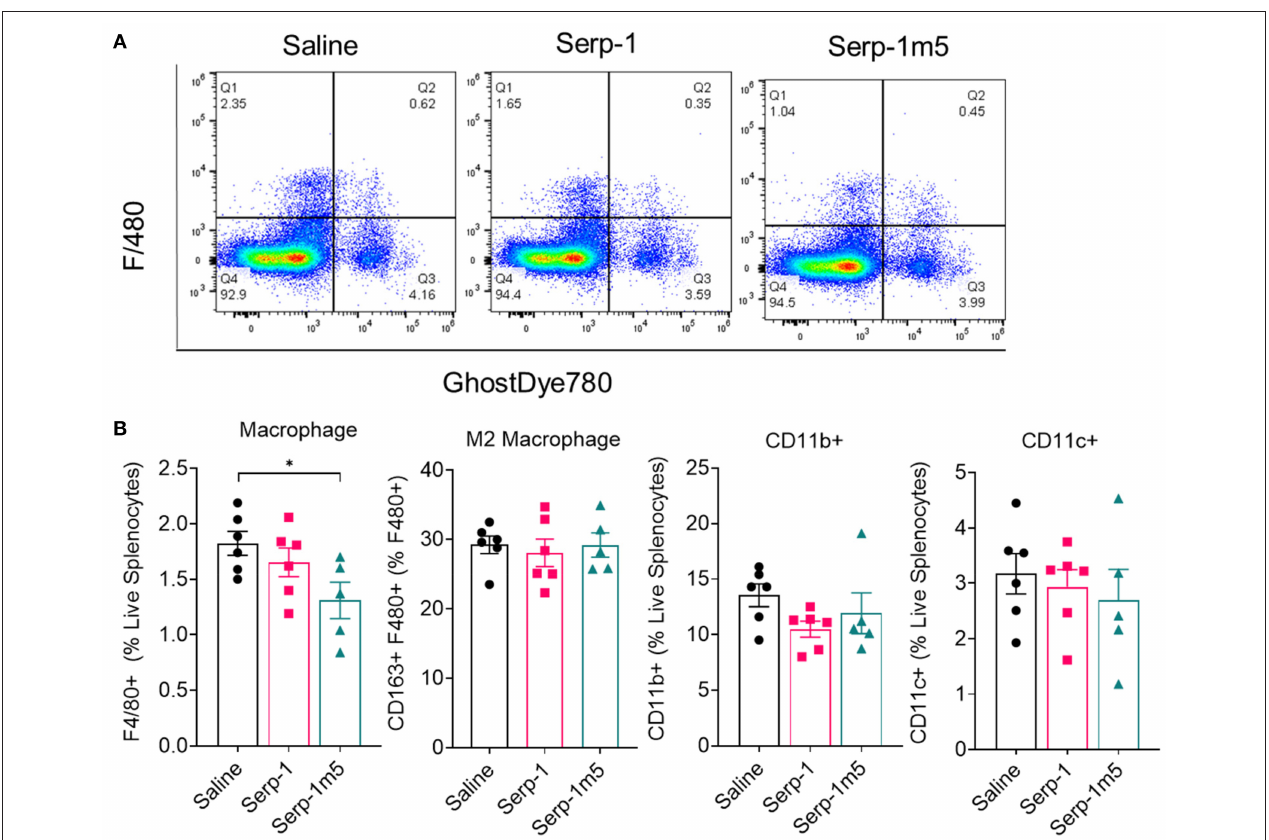
FIGURE 6 | Serp-1m5 treatment reduces macrophages in the spleen of mice after 15 days of induction with pristane. (A) Representative images of flow cytometry for F4/80 + macrophages in live splenocytes demonstrating reduced F4/80 + cells with Serp-1m5 treatment. (B) Flow cytometry of macrophages demosntrated decreased frequency of F4/80 + macrophages ( p = 0.0173) in live splenocytes in Serp-1m5 treated mice compared with saline treated mice while no significant differences in the frequency of CD11b + cells, CD11c + cells in living spleen cells and CD163 + F480 + M2 macrophages in F480 + macrophages among the three groups. * p <